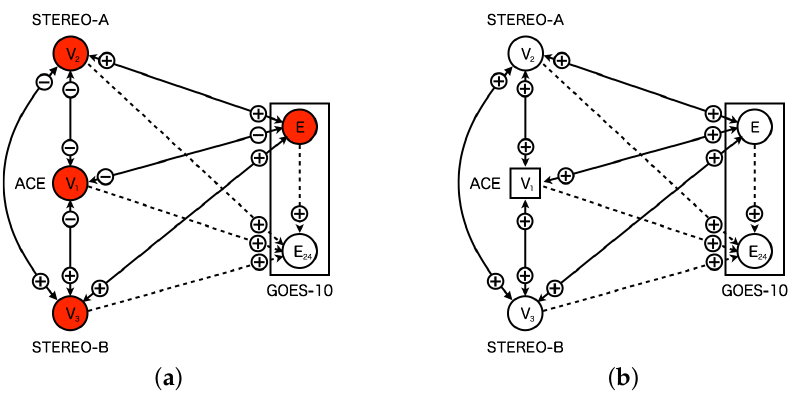
Figure 11. Network snapshot of the dynamic relational network for the test data shown in Figure 9. Figure ( a , b ) show status of the nodes at 48 and 80 steps respectively. The circles and squares indicate the real and virtual sensor nodes respectively. The white (red) colored sensor nodes is normal (abnormal). The credibility for normal status is larger than 0.5, otherwise abnormal. The rectangles indicate region of the satellite. The two sensors of GOES-10 is shown in the regions of the rectangles. The solid lines indicate diagnosis flow of mutual diagnosis. The dashed line indicate diagnosis flow from real sensors to virtual sensors for prediction. The marks plus (minus) indicate diagnosis result normal (abnormal) from source nodes to target nodes. ( a ) Step = 48 (After the real sensor for ACE failed); ( b ) Step = 80 (After the virtual sensor for ACE is